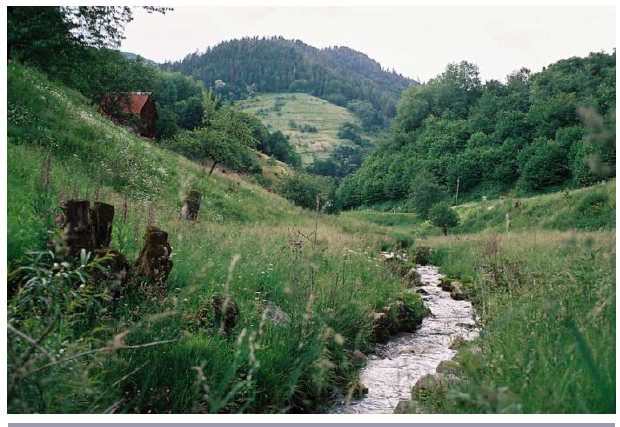
Fig. 2 . Bermersbach valley (photo: Ziegenfreunde Bermersbach